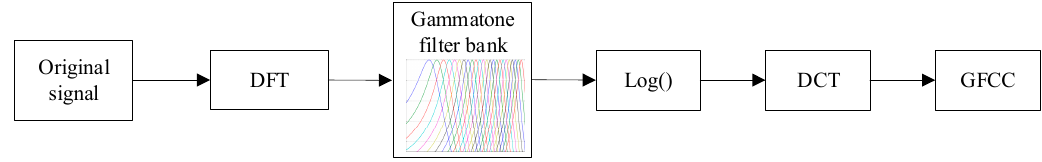
Figure 1. The process of the Gammatone frequency cepstral coefficient (GFCC).